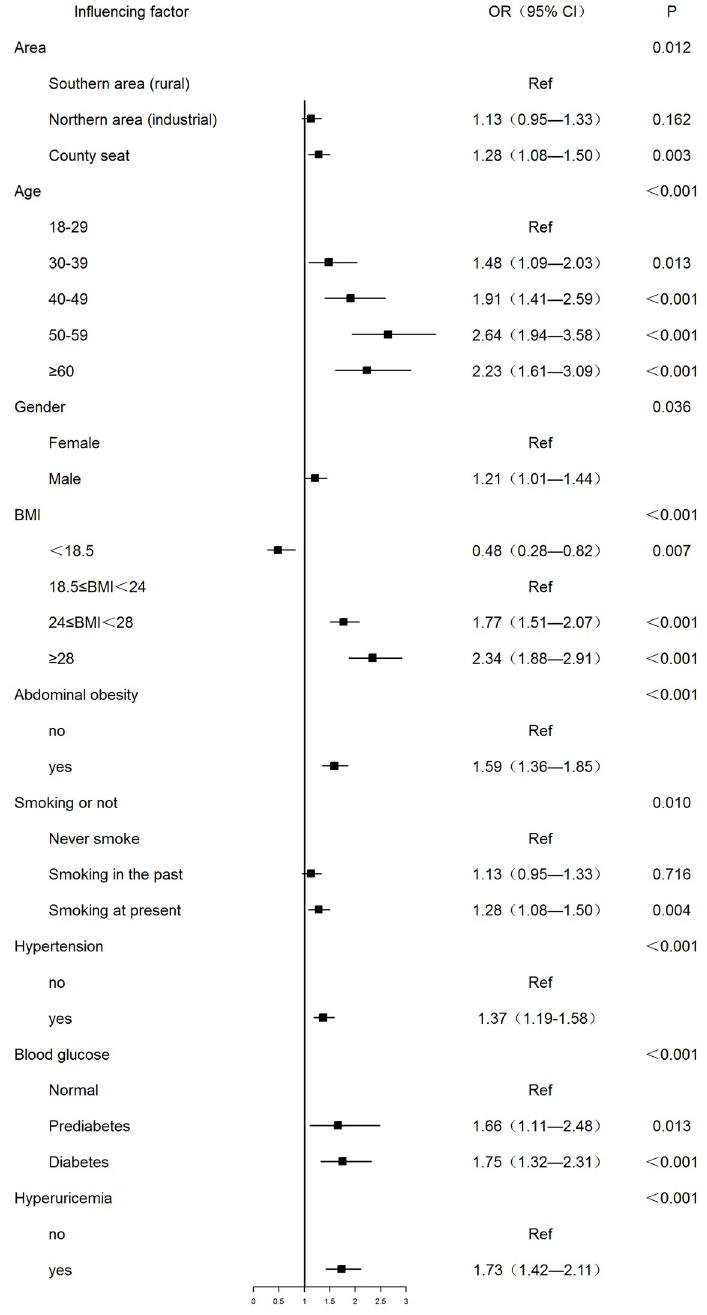
Fig 2. Multivariate logistic regression analysis of factors influencing